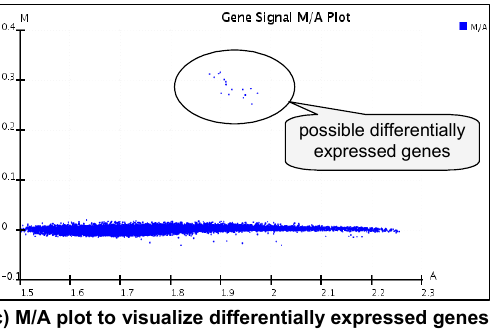
Figure 5: Interactive analysis and of gene expression